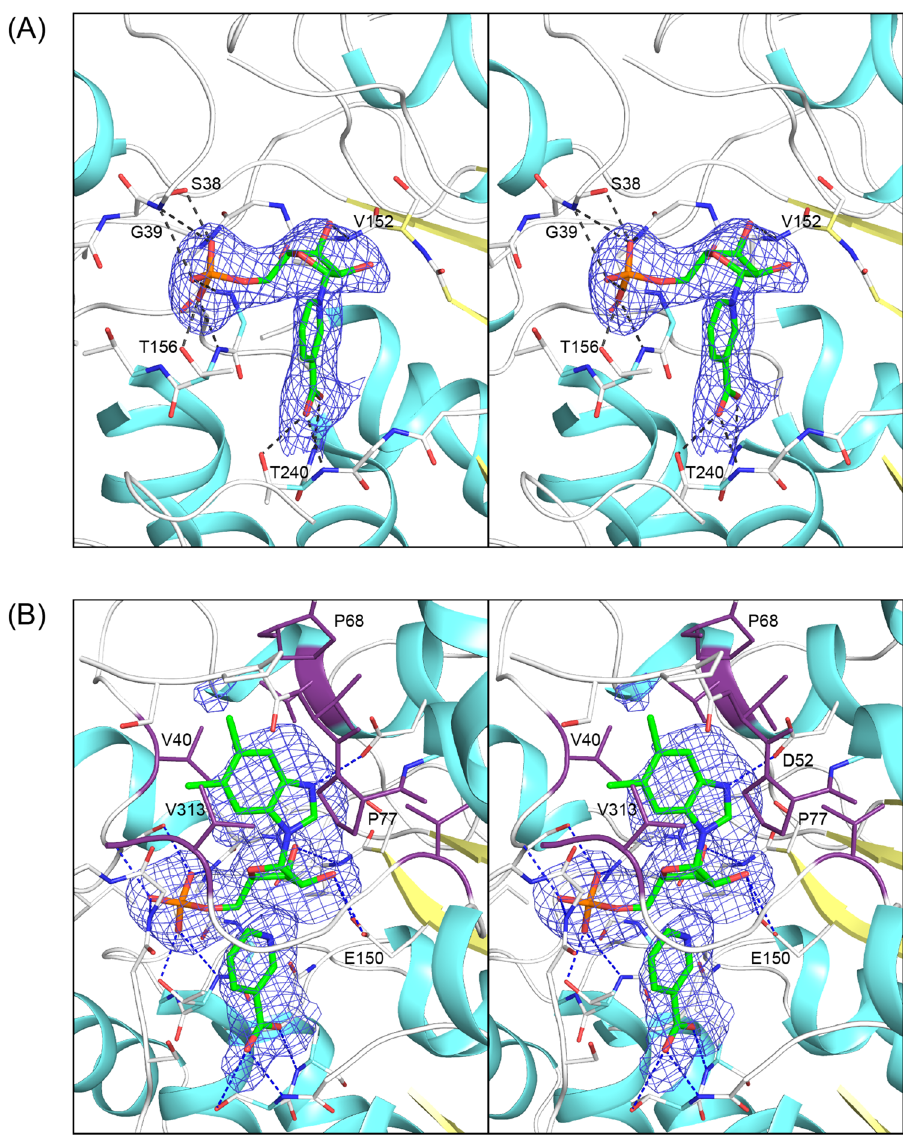
Figure 5. Stereo electron density for NaMN and α-RP and nicotinic acid and their hydrogen bonding interactions. Shown in stereo in ( A ) and ( B ) are the observed electron densities for NaMN and α-RP and nicotinic acid, respectively. The omit maps were calculated with coefficients of the form F o − F c where F o and F c were the native and calculated structure factor amplitudes, respectively. The map was contoured at 2.5σ. ( A ) shows the extensive hydrogen bonding interactions of the nicotinamide ring, ribose sugar, and phosphate moiety. The same interactions are observed for these moieties in the active site that carries α-RP and nicotinic acid, together with the interactions with DMB. ( B ) shows the side chains that surround the nitrogenous base which are mostly hydrophobic, however there is a hydrogen bond between N3 of DMB and Oγ of Asp